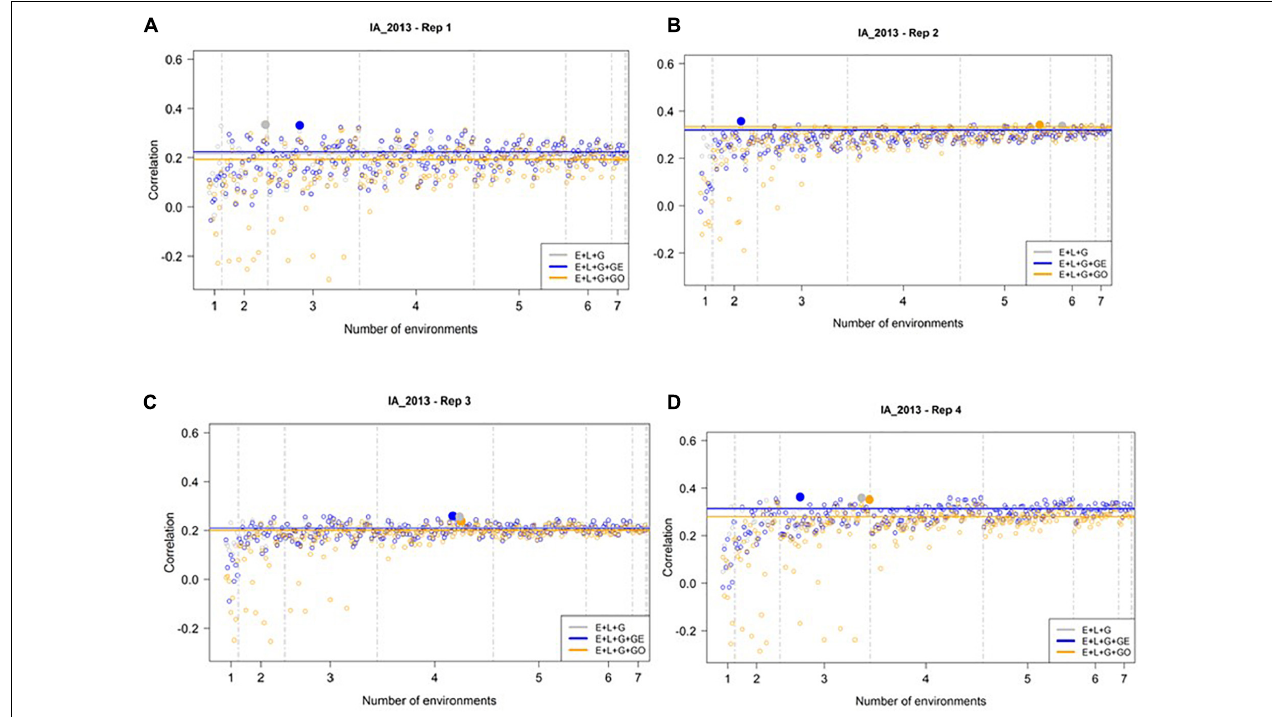
FIGURE 3 | Observed prediction accuracy of grain yield in kg ha − 1 at IA_2013 across multiple genomic prediction (GP) models and training environments. Four random samples of 500 genotypes from the SoyNAM panel are presented in panels (A–D) . For each panel, the X -axis is the specific number of environments considered for training the GP model, sorted from smallest to largest number of training environments; and the Y -axis shows the prediction accuracy, quantified as the Pearson correlation coefficient between the observed phenotypic values and the genomic estimated breeding values. The results in grey depict the GP model without any genotype-by-environment (G × E) interaction effects, while the results in blue depict the GP model with G × E interaction effects, and finally the results in yellow depict the GP model with G × E interaction effects that incorporates environmental covariates (ECs). The highest observed prediction accuracies across any training set from each GP model are highlighted by a solid circle of the same color, while the prediction accuracies of the three models obtained using all eight of the possible environments in the training set are shown as horizontal lines of the same color. These panels show that not all eight environments are needed to obtain the maximum possible prediction